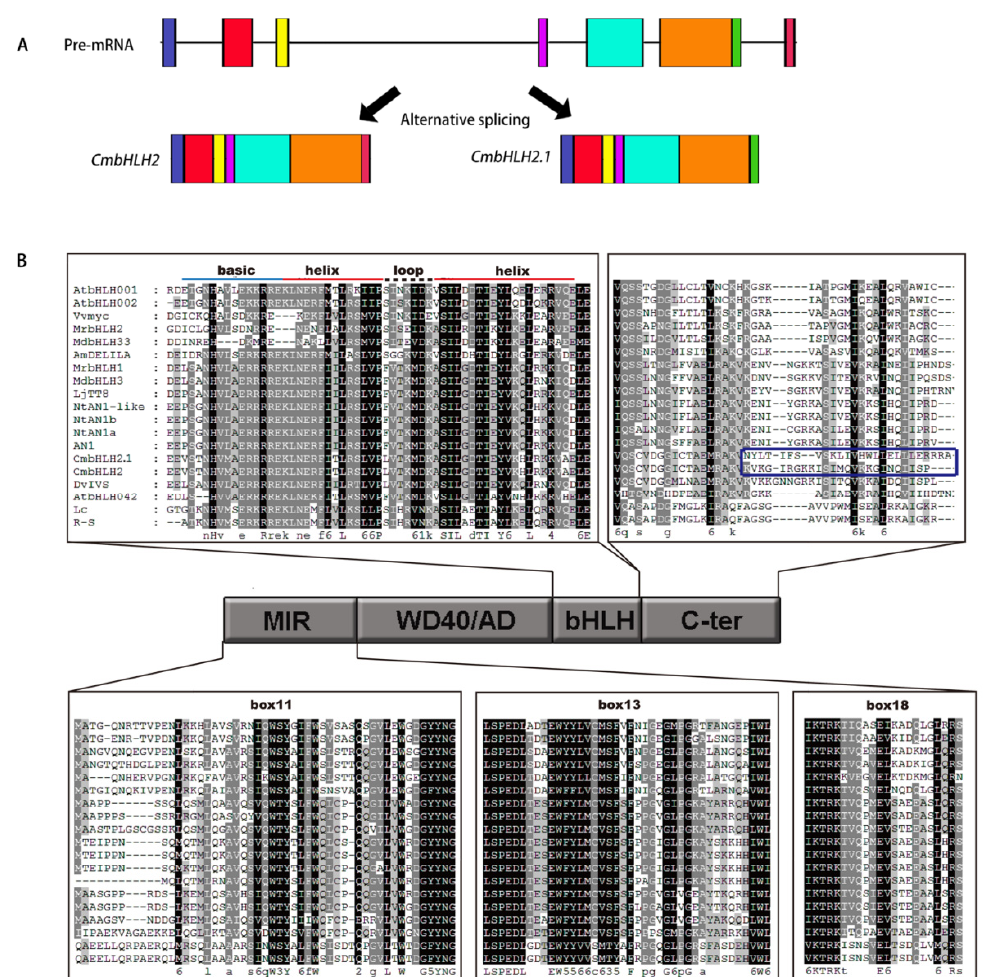
Figure 5. Structure diagram and protein sequence alignment of two bHLHs. ( A ) Structure diagram of two alternative splicings of bHLH2 Pre-mRNA. Rectangles with different colors indicate exons. ( B ) Protein sequence alignment of two bHLHs together with IIIf bHLHs from other species. The conserved basic helix-loop-helix domain was marked with red and blue lines. The MIR (MYB interact region) includes box11, box13 and box18. The sequence differences between two CmbHLHs were marked with a blue box.